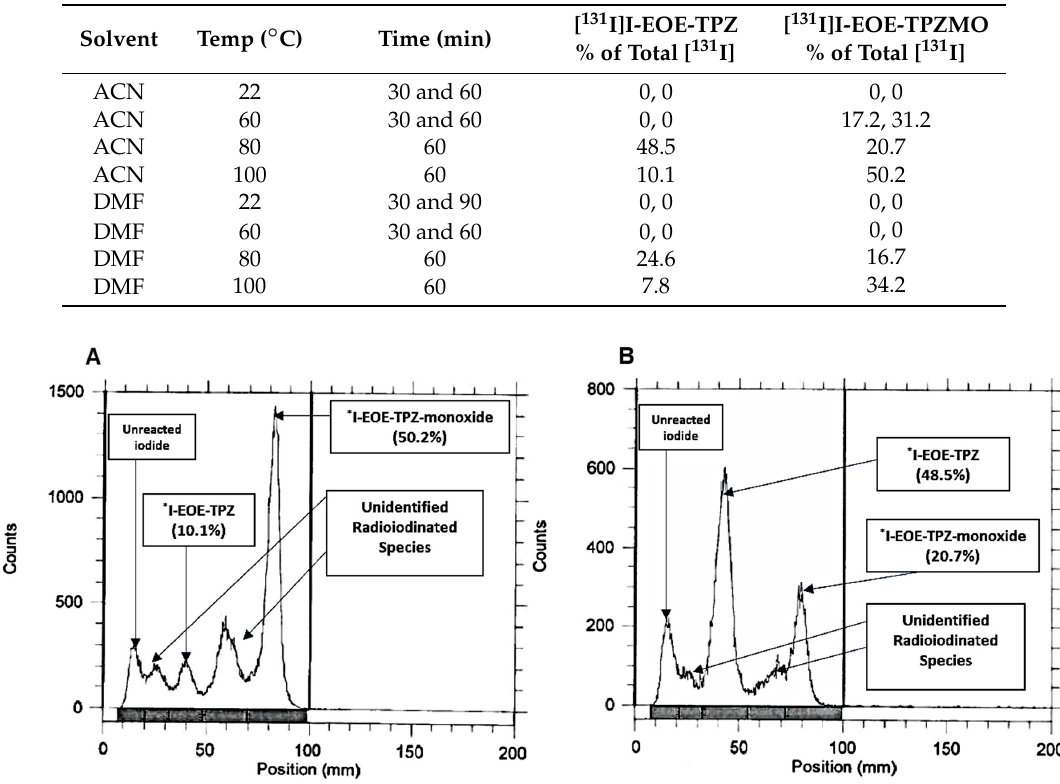
Figure 2. RTLC of the reaction mixture post-nucleophilic radioiodination of P1 by [ 131 I]iodide in ACN after 60 min at 100 °C ( A ) and at 80 °C ( B ).